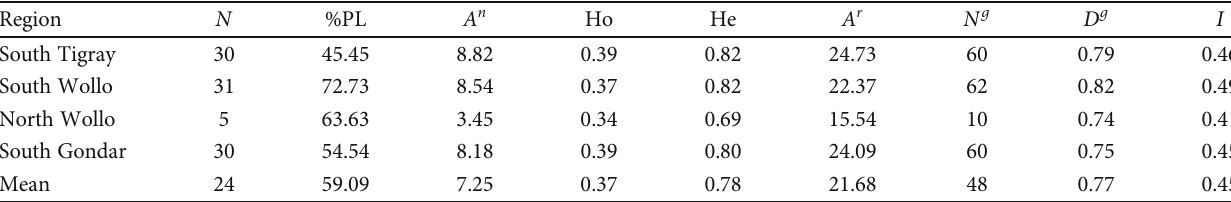
Table 2: Genetic diversity estimates of regions of collection based on percentage polymorphism, allele numbers, observed and expected heterozygosity, allelic range, gene number and diversity, and Garza-Williamson